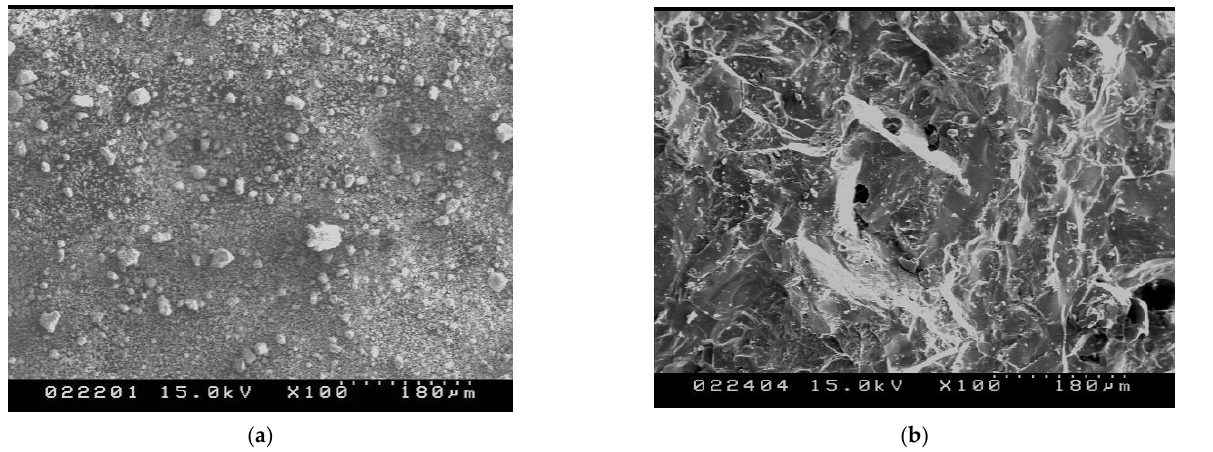
Figure 2. Results of SEM analysis of the dust before ( a ) and after ( b ) ISV treatment .